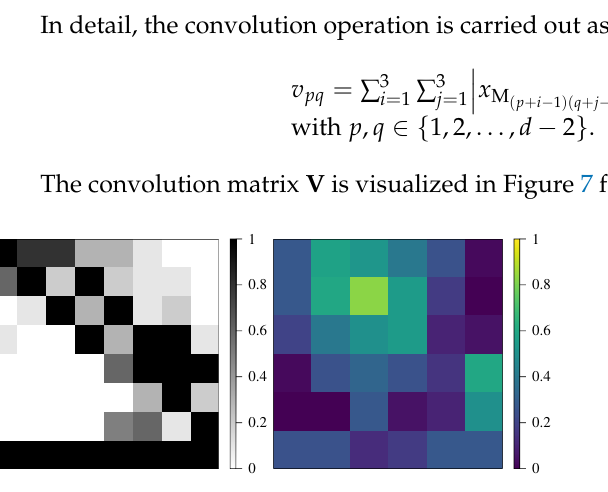
Figure 7. ( Left ): sample geometry. ( Right ): intermediate result (convolutional matrix V ) in the checkerboard pattern